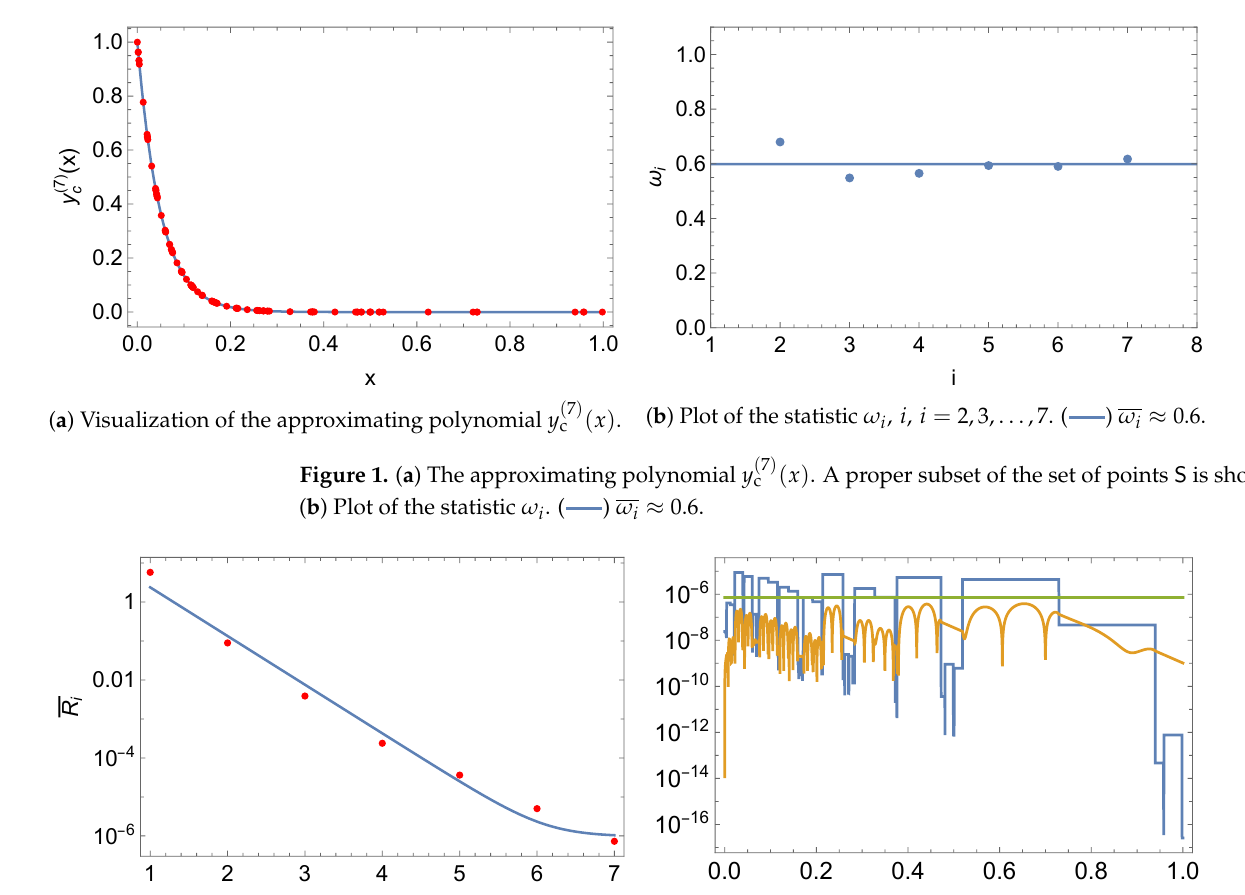
Figure 2. ( a ) Fitting the upper bound (24) with the set R . ( b ) Visualization of the residual, absolute local approximation error, and the mean value.